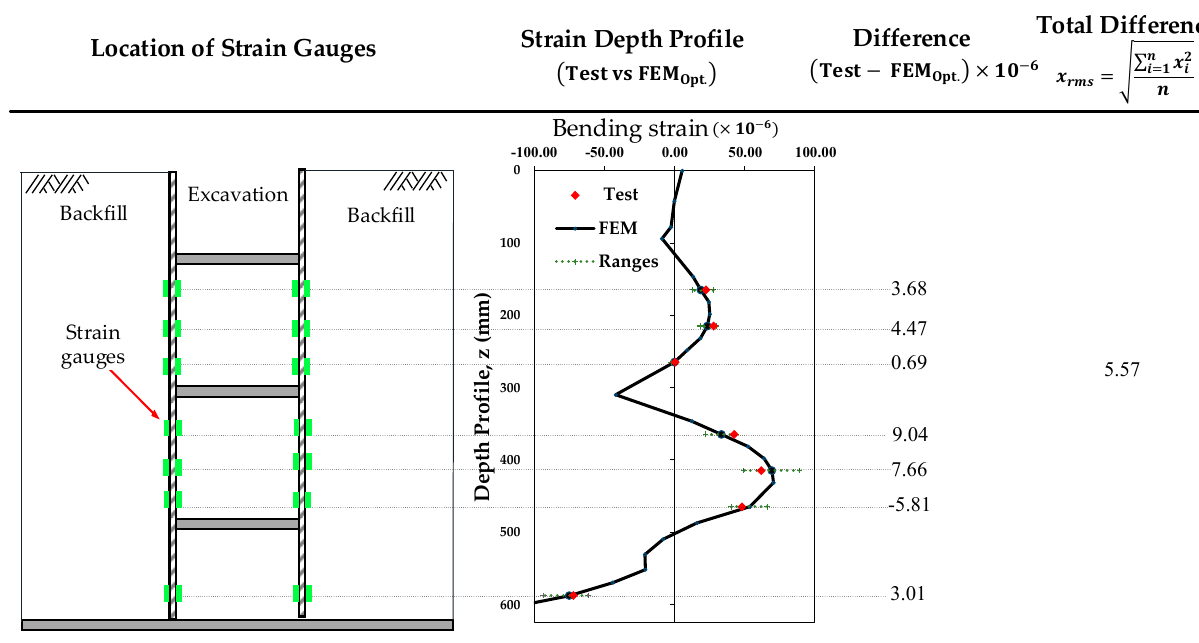
13 of 16 Figure 9. Response (bending strain) of the updated numerical model. A comparison of the magnitude of the bending strain from the updated numerical